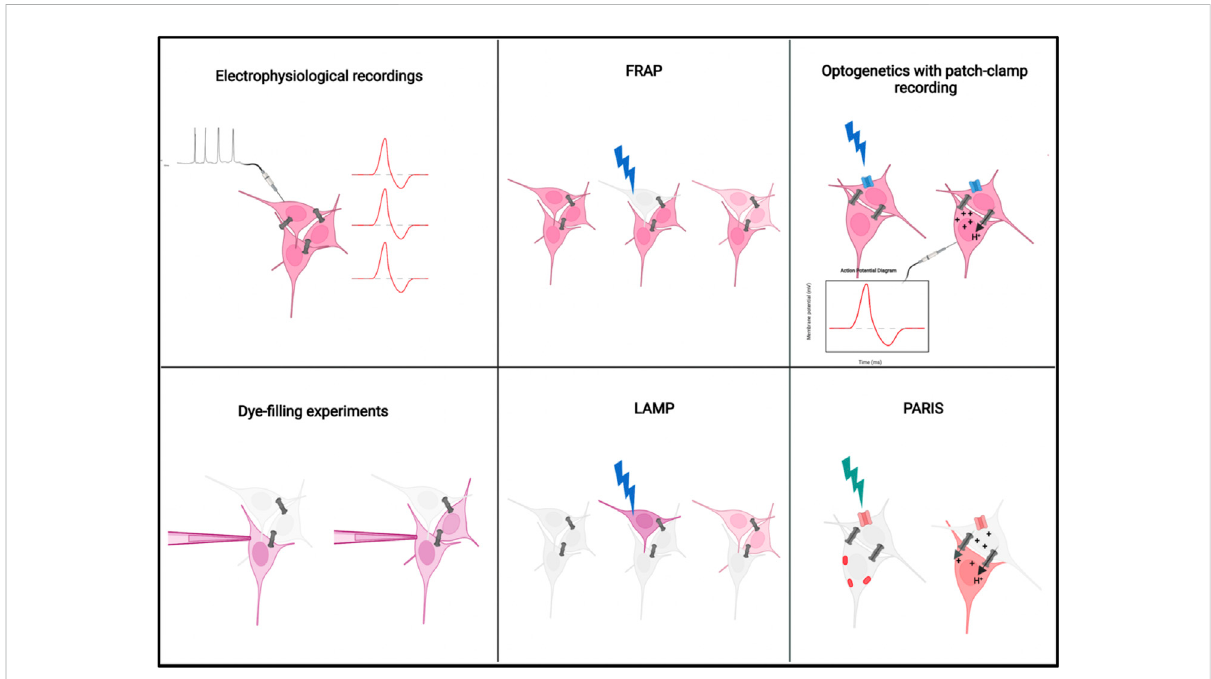
FIGURE 3 Methods to visualize electrical synapses: The schematic represents the methods currently available to visualize electrical synapses in the nervous system. Electrophysiological and dye- fi lling methods are invasive and technically challenging. FRAP and LAMP measure the rate of transfer of fl uorescent molecules, hence can be quantitative, but could cause tissue damage. The recent improved methods utilize genetically encoded indicators including channel rhodopsins for optogenetics and ArchT and pHluorin for PARIS. Improvements that address shortcomings for these techniques should help improve the detection of functional electrical synapses among cells. Detailed descriptions of each technique are provided in the text. FRAP, Fluorescence Recovery After Photobleaching; LAMP, Local Activation of Molecular Probe; PARIS, Pairing Actuators and Receivers for optically ISolating gap junctions. Image created using